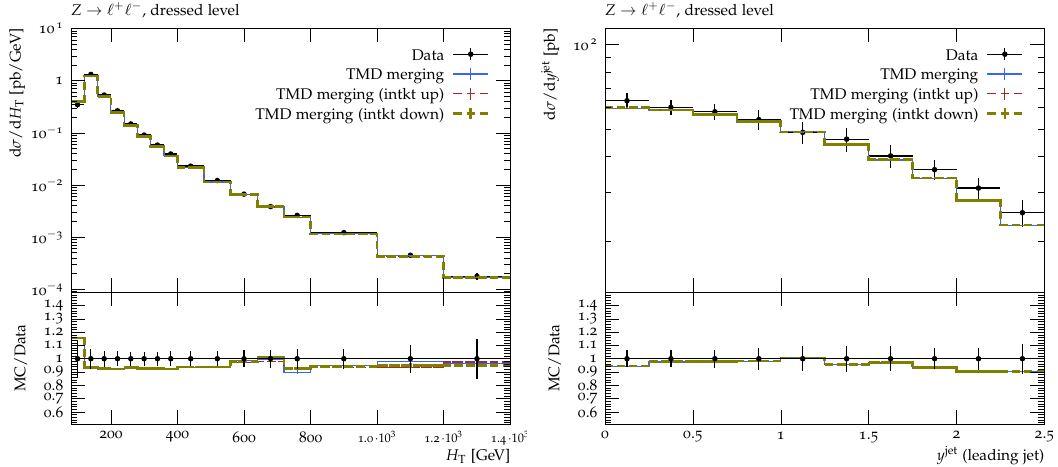
Figure 32 . Scalar sum H T of the transverse momenta of leptons and jets (left), and leading jet rapidity (right) distributions for Z + jets events: intrinsic- k